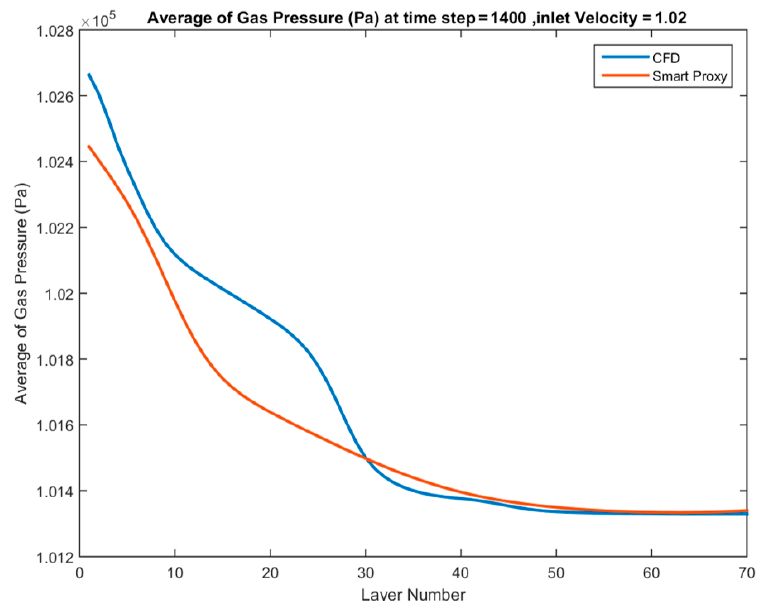
Figure 35. Spatially averaged CFD and smart proxy results for gas pressure (Pa) at time step = 1400 for blind test condition of V in = 1.02 m/s (with 4 static parameters).